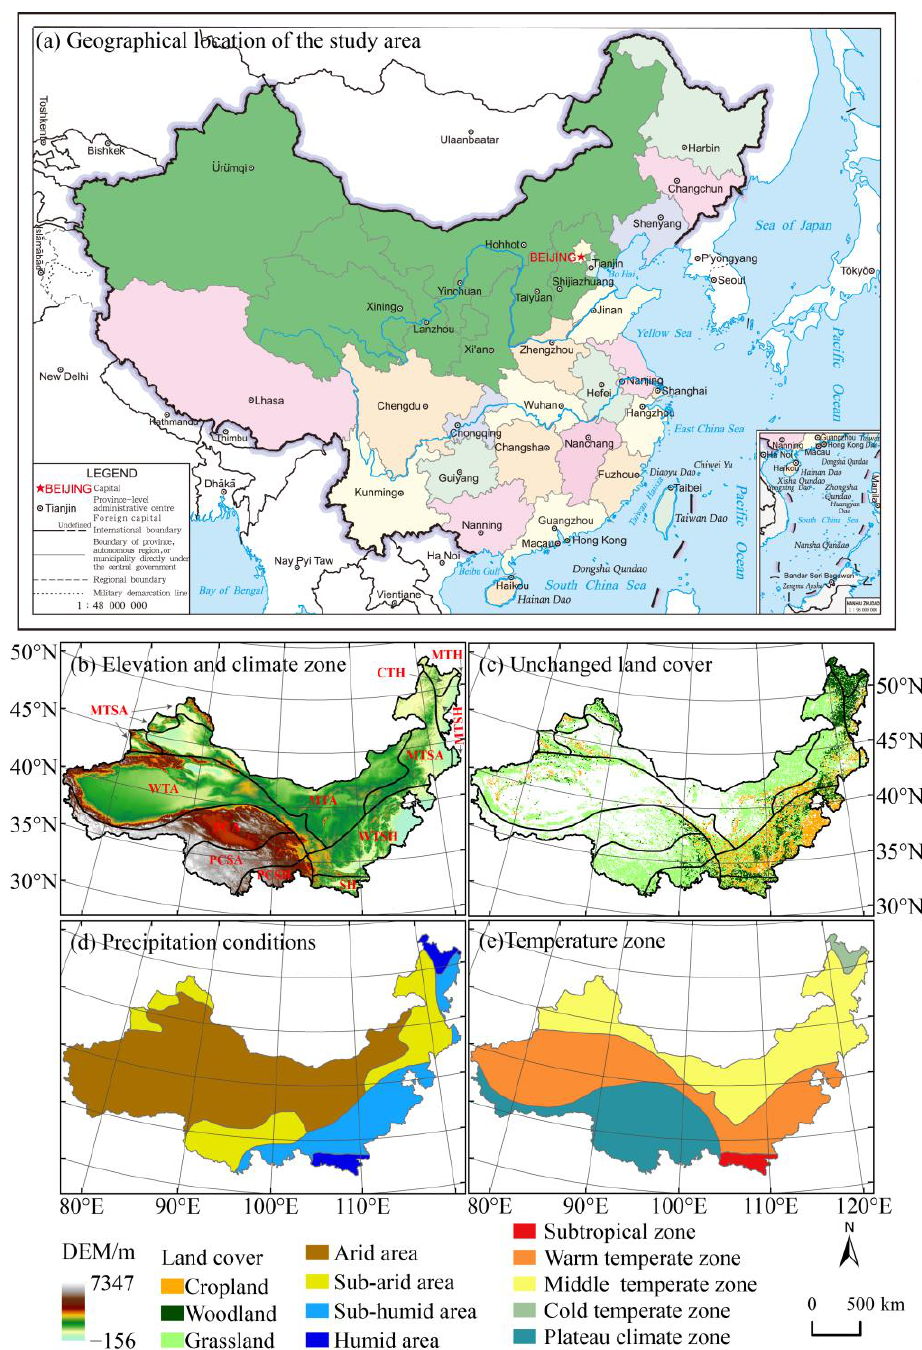
Figure 1. Geographical location of the study area ( a ); elevation and climate zone ( b ); unchanged land cover ( c ), precipitation conditions ( d ); and temperature zone ( e ) in the study area. Table 1. Detailed information on 11 climate zones in the study area.